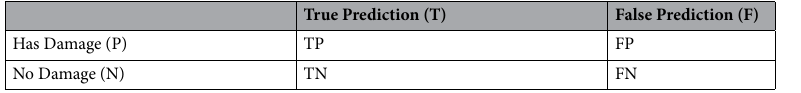
Table 1. Prediction typology in a binary-classification-based damage